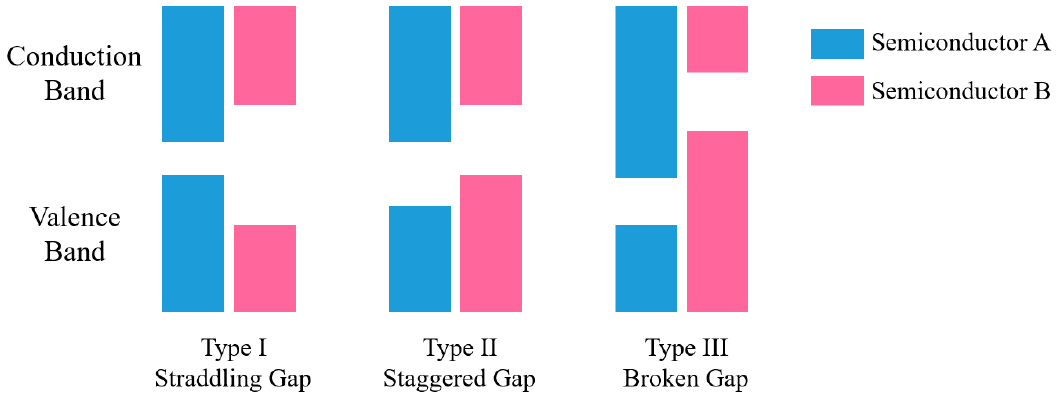
Figure 2. Illustration of type I, II, and III semiconducting heterostructures.